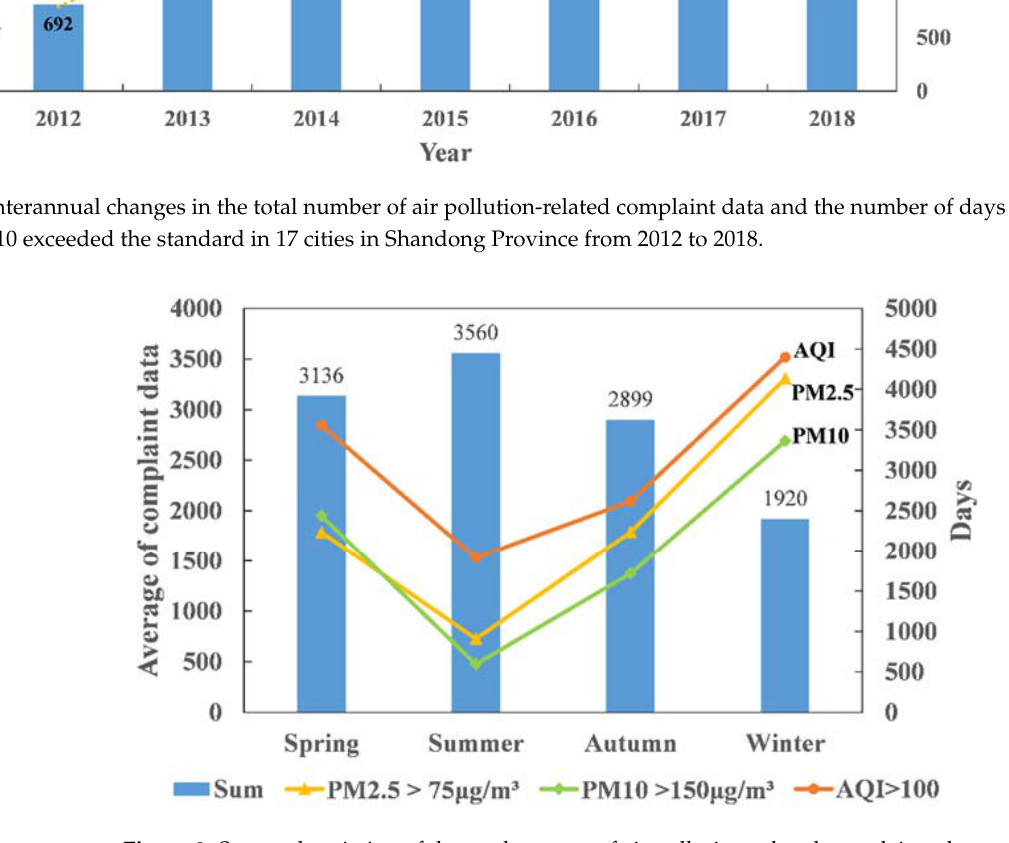
Figure 3. Seasonal variation of the total amount of air pollution ‐ related complaints data and